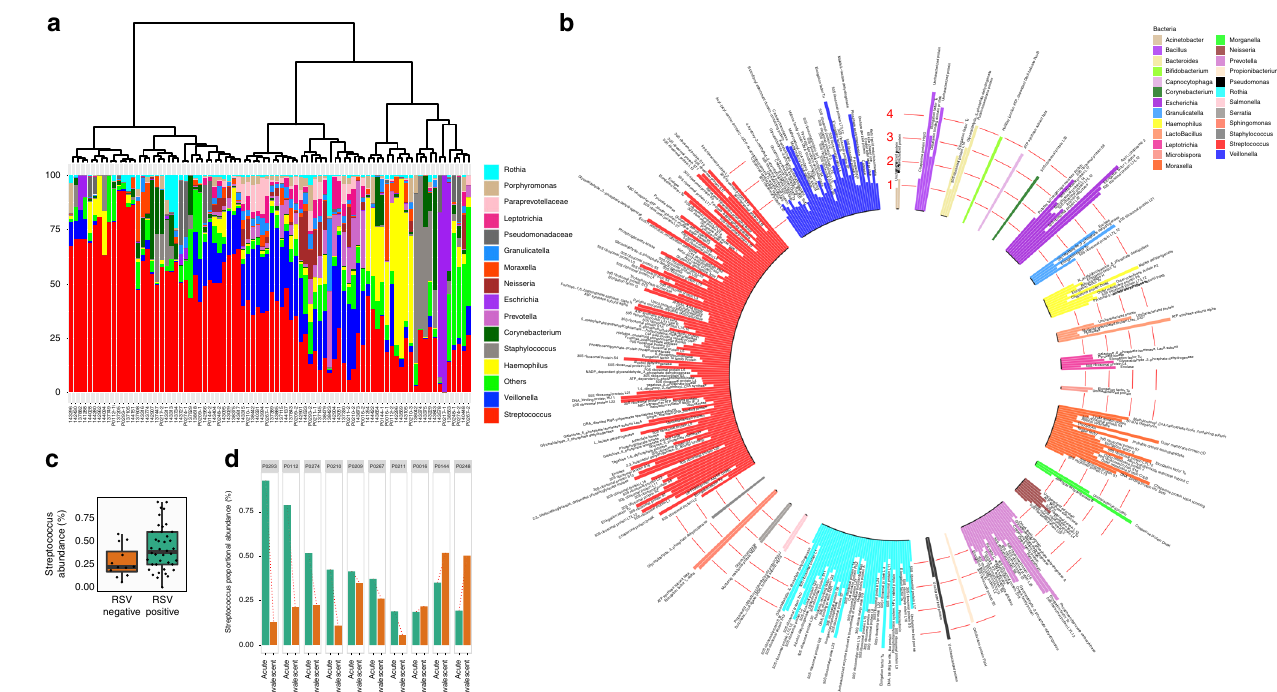
Fig. 1 The composition of the airway microbiota. a Dendrogram visualising the hierarchical clustering of individual microbiomes of 84 individual children on the basis of the Bray – Curtis dissimilarity matrix. The relative abundance of the 15 highest-ranked operational taxonomic units are presented for each study participant as stacked bar charts. operational taxonomic units under the ‘ others ’ heading are an aggregate of bacteria that occurred at low abundances (<1%). The taxonomic identities of these low-abundance operational taxonomic units are presented in Supplementary Data 1. b The proteome of the upper airway microbiota (metaproteome) was characterised by mass spectrometric analysis using airway samples from 84 children and the results are presented in a circular bar chart. Each bar represents the mean expression level of one bacterial protein. Values on the y -axis correspond to MS protein expression levels (log 10 reporter corrected intensity). Most of the bacterial operational taxonomic units that were identi fi ed in metagenomic analyses of the airway microbiota were also identi fi ed in the proteome. The highest number of protein identi fi cations belonged to the genus Streptococcus and comprised mainly of ribosomal proteins and proteins involved in energy metabolism pathways. c The abundance of Streptococcus in the airway was compared between RSV- positive and RSV-negative children. RSV-infected children had a higher abundance of airway Streptococcus compared to RSV-negative children. d The effect of RSV infection on Streptococcal colonisation of the upper airway was characterised using a subset of 10 children from whom nasopharyngeal and oropharyngeal swabs were obtained during acute RSV infection and at convalescence, approximately one month later. Seven out of 10 children (70%) exhibited declines in the airway abundance of Streptococcus upon recovery from RSV, while for three children, convalescent-stage Streptococcus abundance was either unchanged from the acute time point or was higher. On the box and whisker plot, the bottom line on the box denotes the 25th data percentile (quartile 1), the middle line denotes the median and the upper line denotes the 75th data percentile (quartile 3). The bottom whisker represents data in the lower extremity of the distribution (quartile 1 – 1.5 × interquartile range) and upper whisker denotes the upper extremity of the distribution (quartile 3 + 1.5 × interquartile range). Source data are provided as a Source Data fi